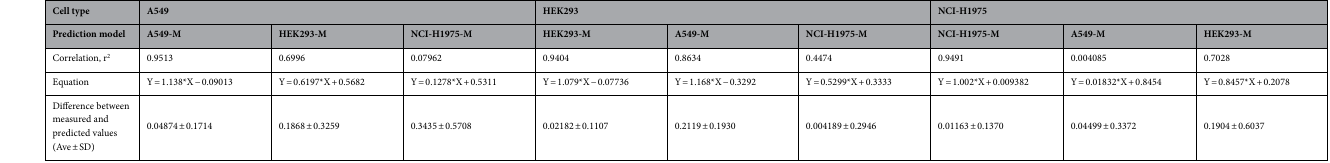
Table 1. Statistical analysis of linear relationship of measured and predicted OD 450 nm